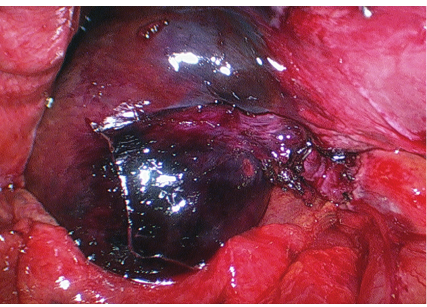
Figure 2: Gallbladder seen following untwisting of the mesentery.